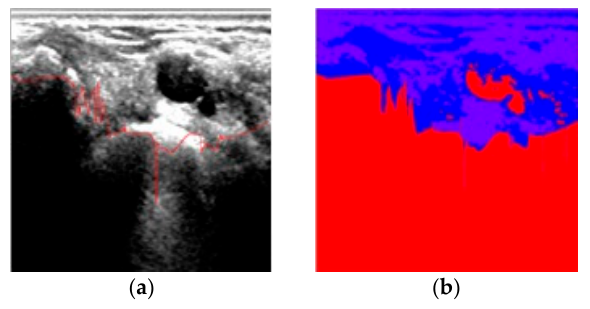
Figure 6. Effect of FCM-based quantization. ( a ) Region of interest, ( b ) FCM quantization. To remove noises and to clarify the target region effectively, we first apply an “ex- pansion” operation to the image. The “expansion” operator expands the “white pixel” in size so that the bright area can be more emphasized. The brighter area is then expanded by filling adjacent neutral pixels as white and connecting these pixels to form the candi- date object. The 8-directional contour tracking algorithm that is explained in detail in [28] is applied to remove such noises using masks and directional search. The object found in the search process that is less than 10% of the given image or pixels surrounded by zeros are removed as noise. The effect of the 8-directional search is shown in Figure 7.